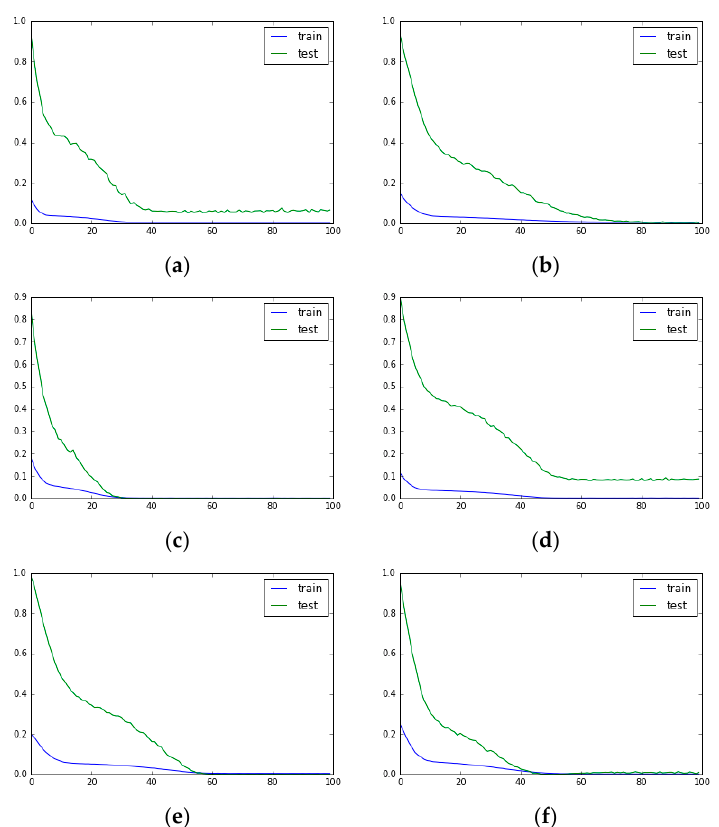
Figure 13. Training process and prediction result using CLNN directly.